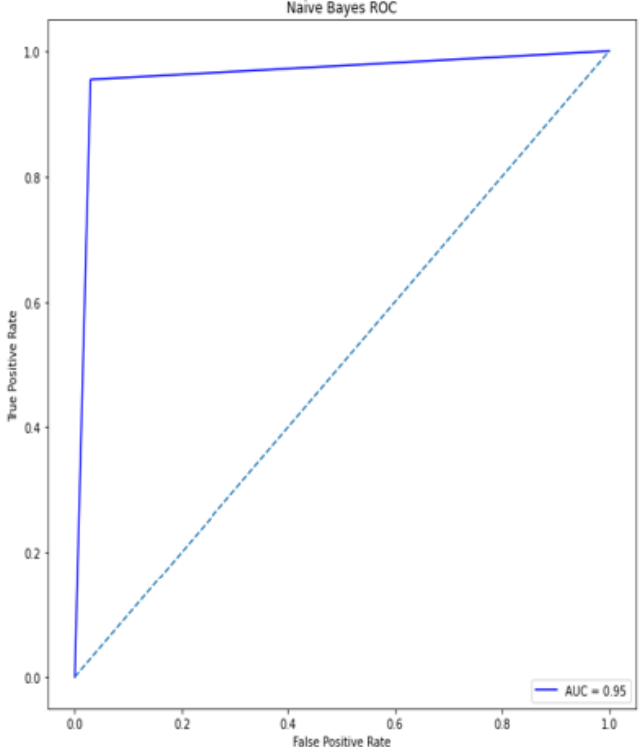
Figure 16. ROC/AUC of KNN.